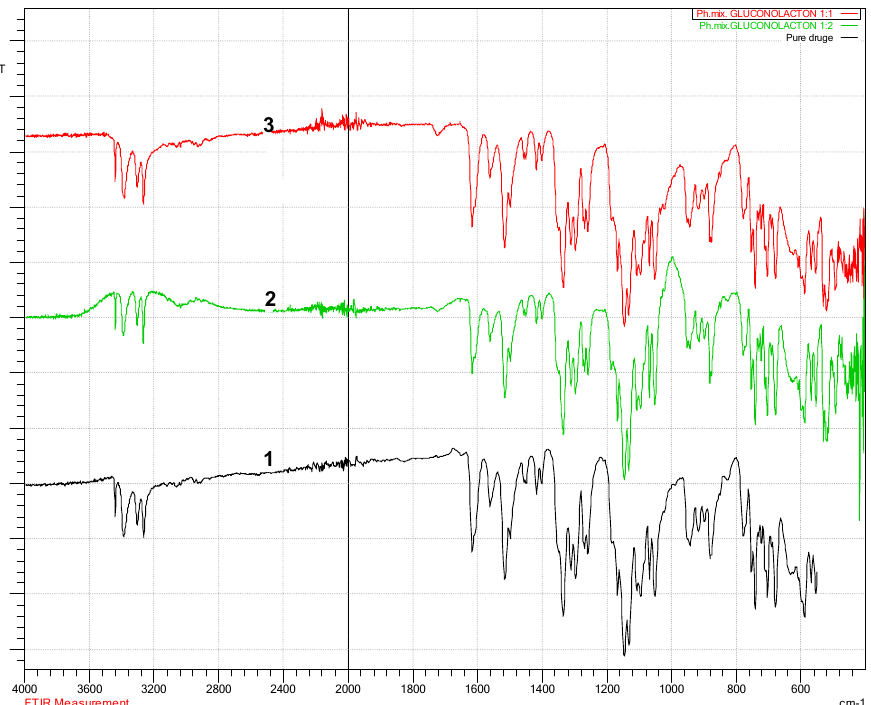
Figure 6. Drug-gluconolactone a new peak (marked with a circle) appeared between 1715–1730 cm − 1 due to ketone functional group C=O stretching. 1 (black colour): Pure bendroflumethiazide; 2 (green colour): Drug: gluconolactone 1:2; 3 (red colour): Drug: gluconolactone 1:1.